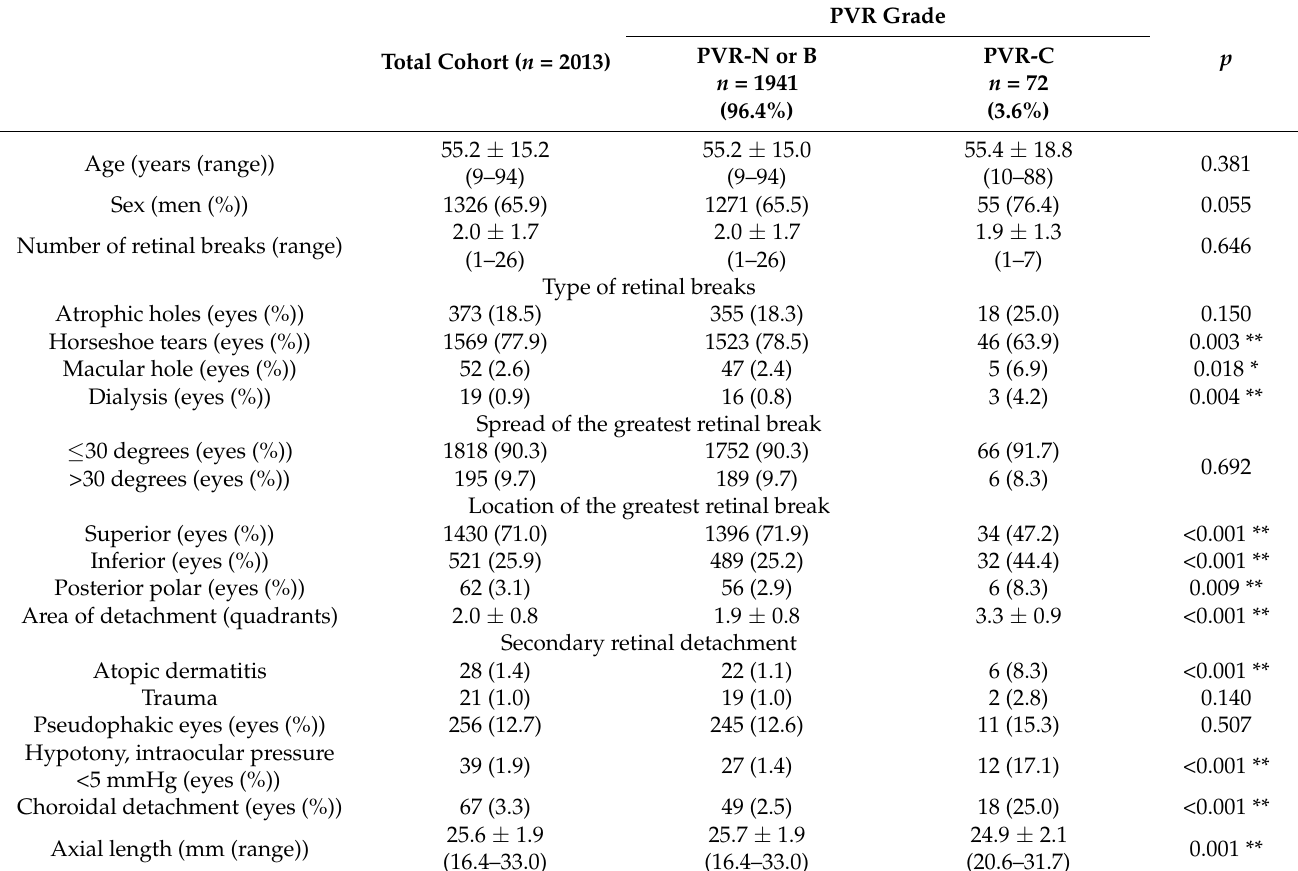
Table 1. Baseline characteristics of the participants.